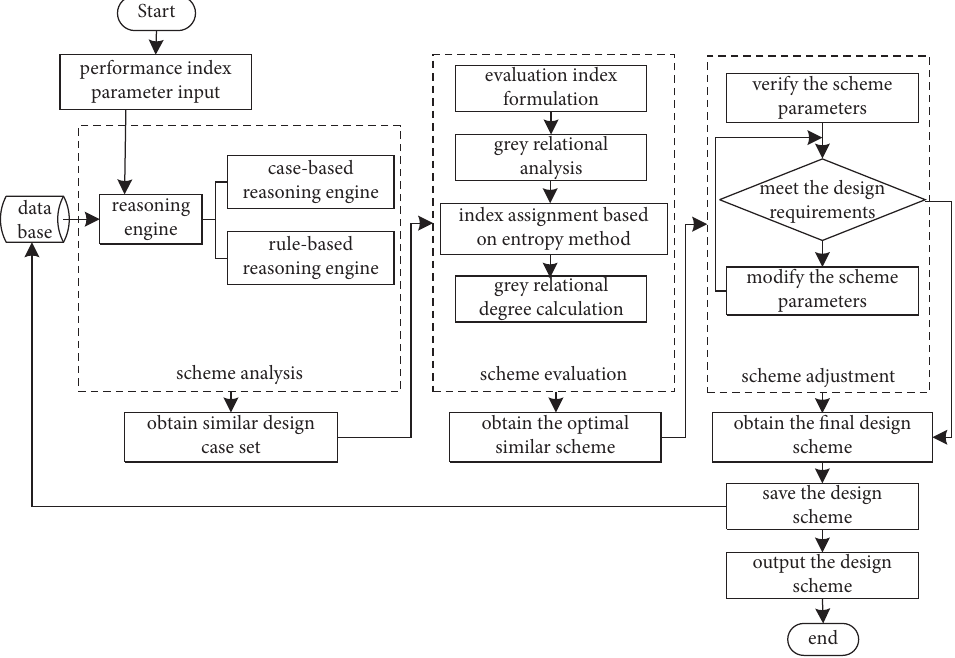
Figure 3: Scheme reasoning and decision-making